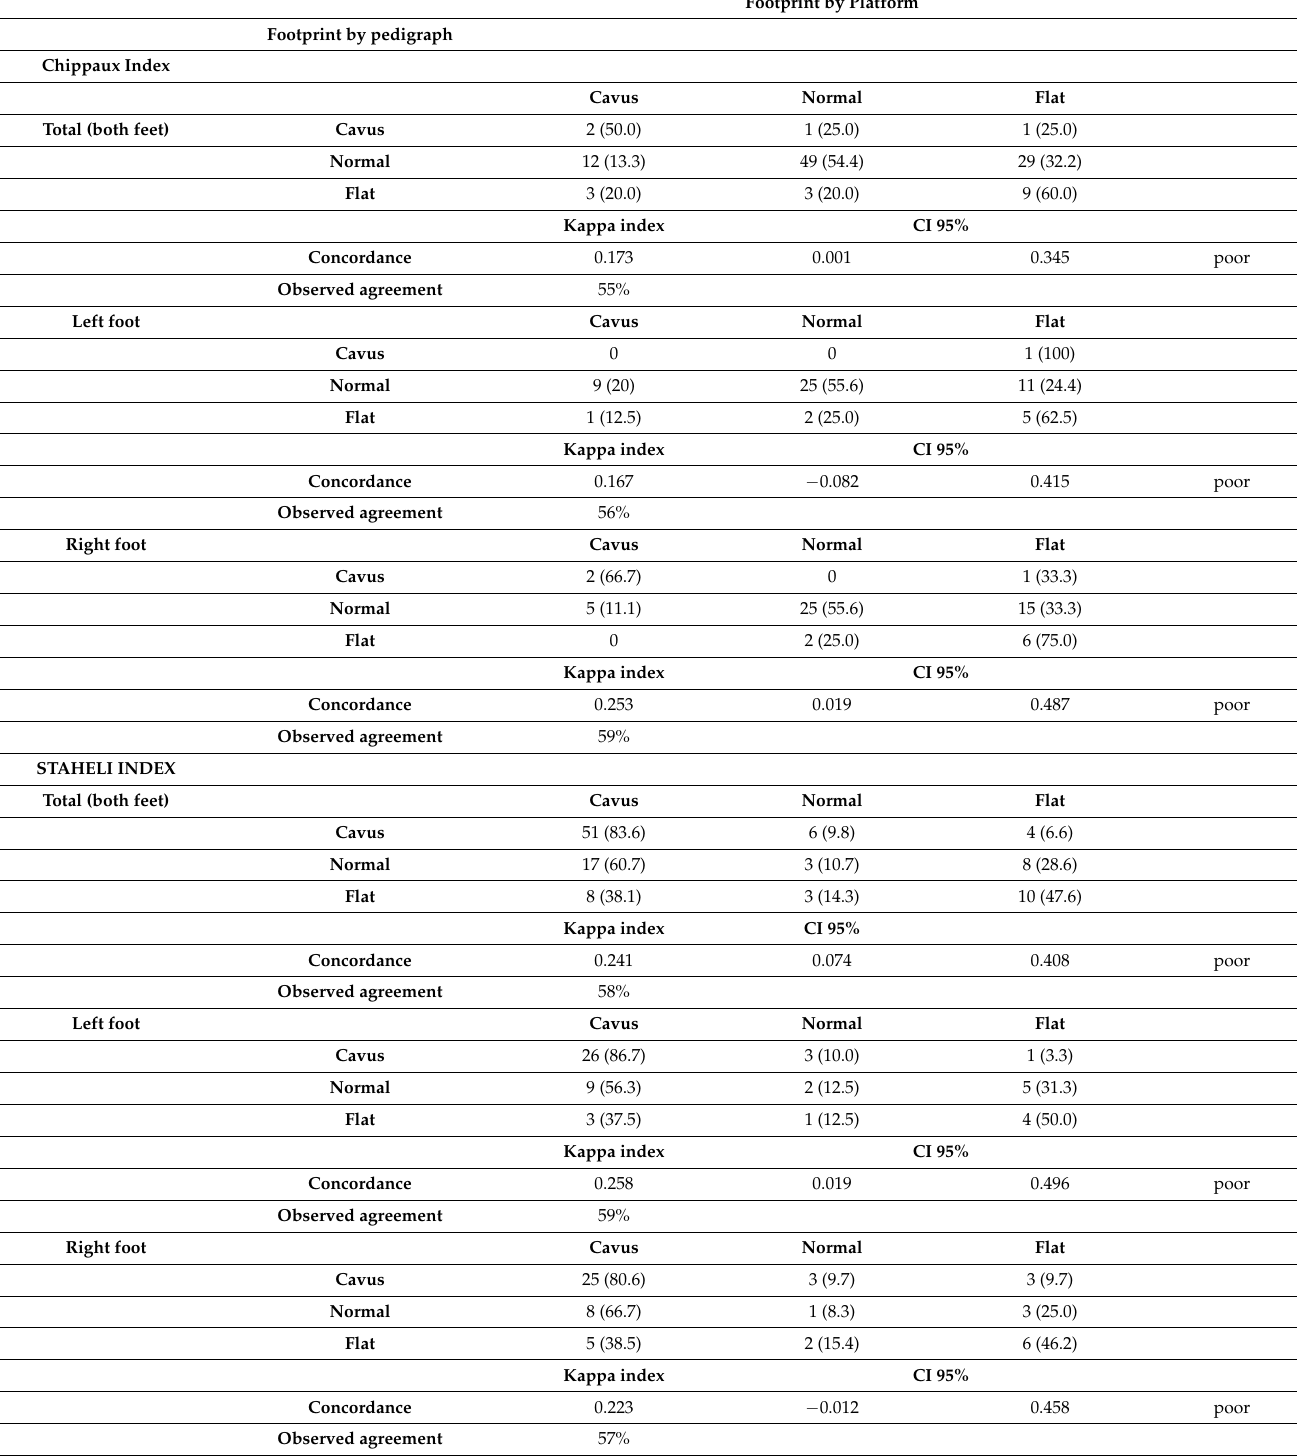
Table 4. Concordance between the Chippaux and Staheli index according to